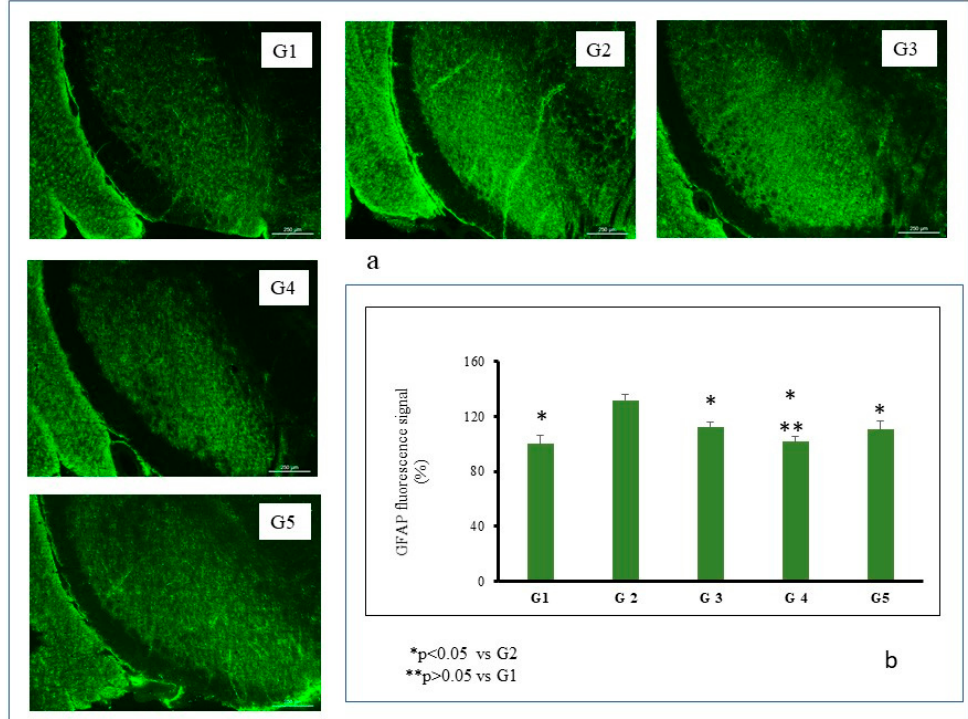
Figure 5. Representative GFAP fluorescence ( a ) and GFAP fluorescence signal ( b ) in coronal brain slices at the level of the substantia nigra for all animal groups. Control group (G1); RT-treated control group (G2); RT-treated animals also receiving: formulation MP-TC4 (G3), formulation NP-TC3 (G4), and TC in saline (G5). GFAP (glial fibrillary acidic protein), RT (rotenone), TC (tolcapone).